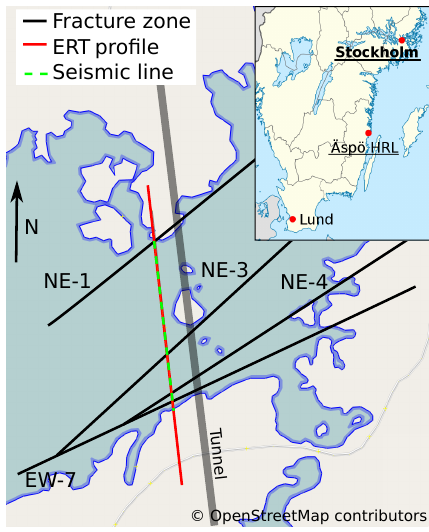
Figure 1. The location, major fracture zones (black lines) after Stanfors et al. (1999), the scheduled ERT profile (solid red line) and the seismic (dashed green) line at Äspö Hard Rock